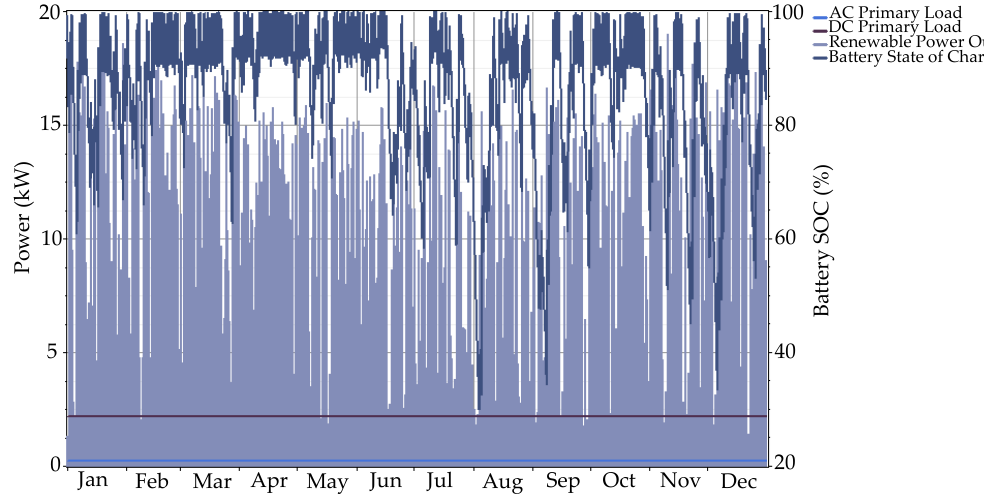
Figure 6. The average hourly power contribution of the PV array and battery bank.